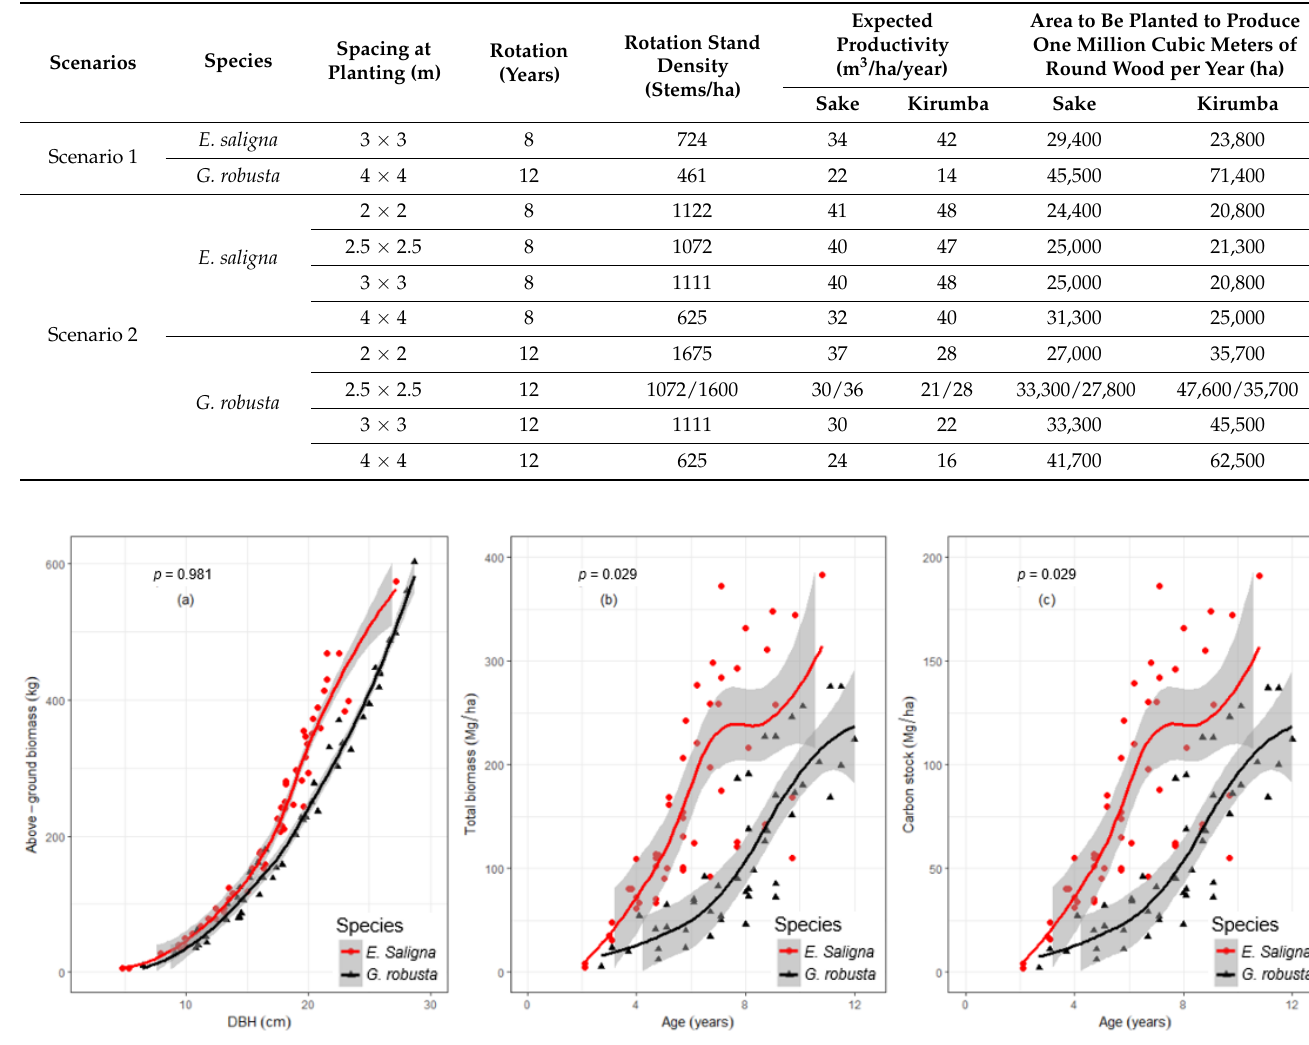
Table 6. Carbon stock, long-term CO 2 fixation and financial potential of carbon credits in E. saligna and G. robusta plantations in North Kivu. The carbon stock was calculated from models 5 (for E. saligna ) and 10 (for G. robusta ). Long-term fixed CO 2 and the financial potential of carbon credits were deducted from the carbon stock following the methodology described in Section 2.4.6. The rotation stand density corresponds to the stand density after thinning (see Table 4).